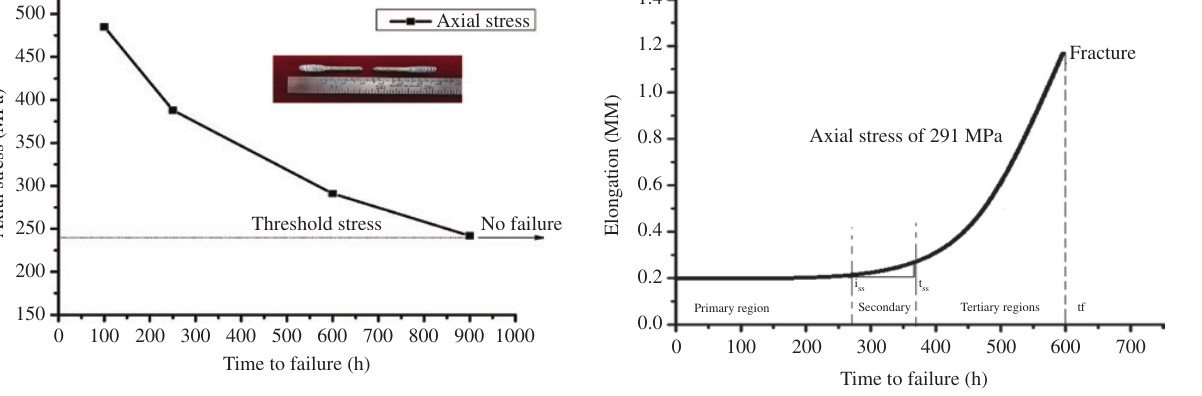
Figure 9: Corrosion elongation curve in a 3.5 wt.% NaCl solution and its